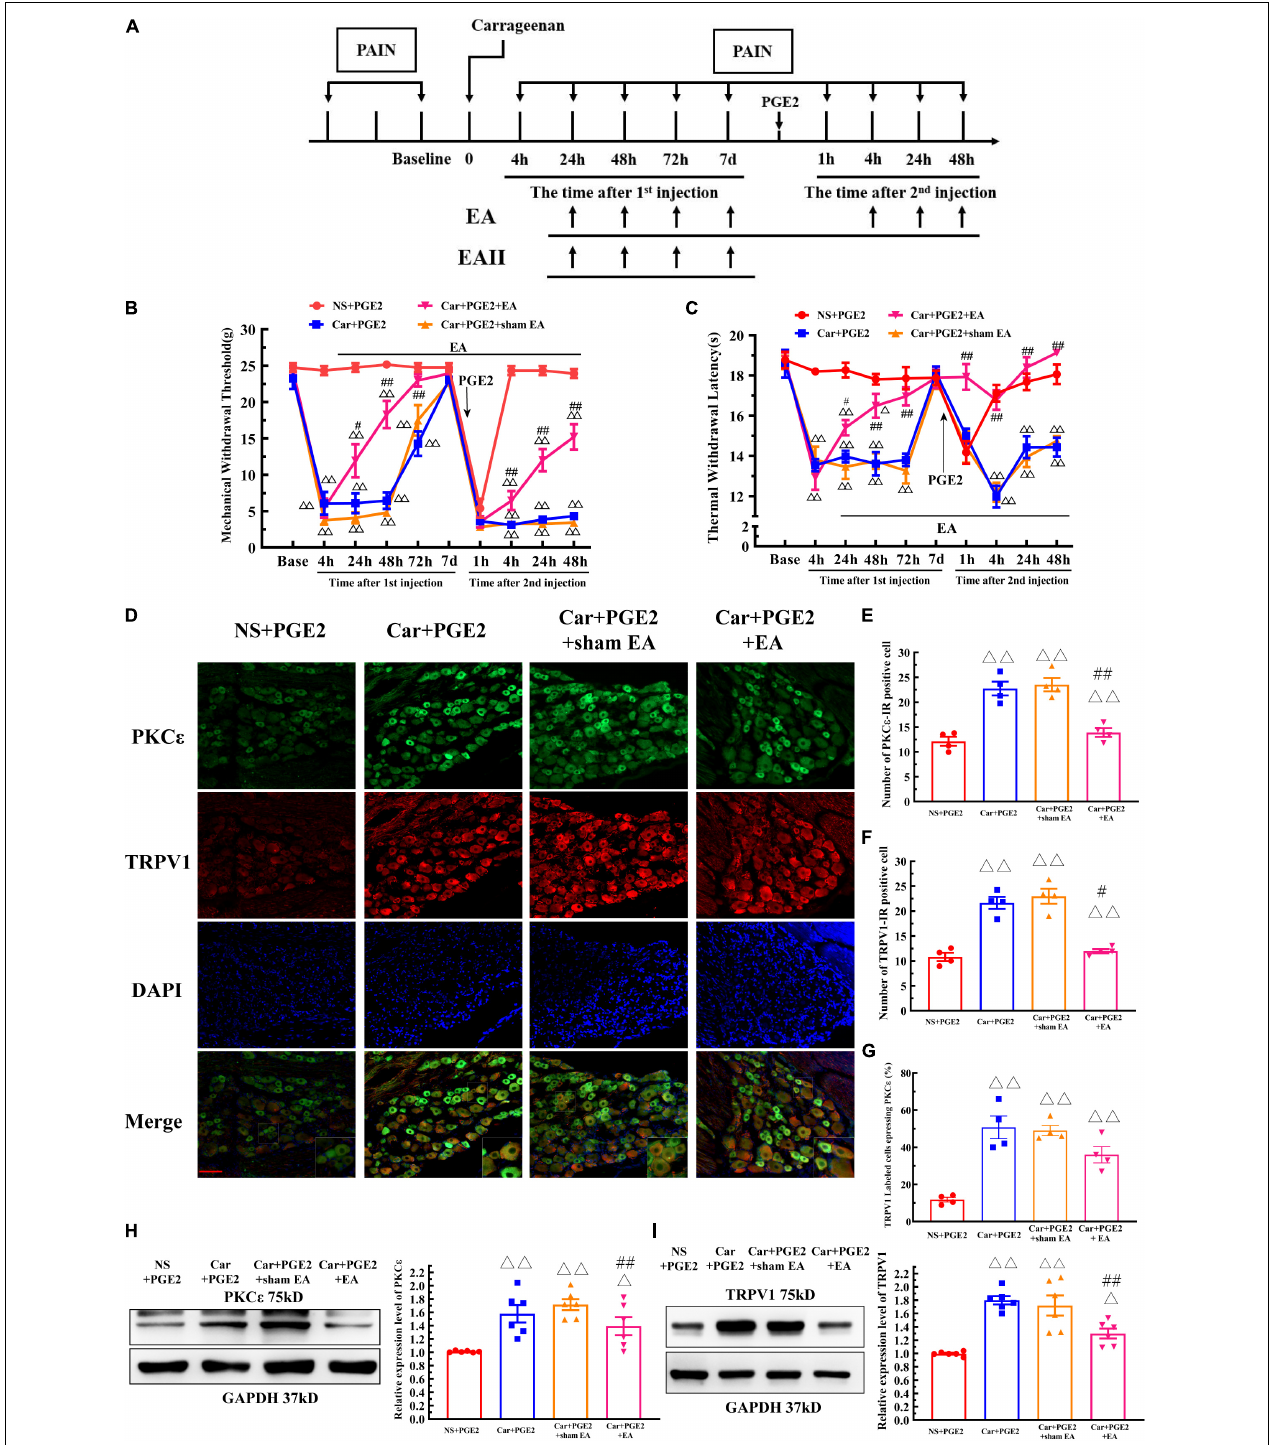
FIGURE 6 | Electroacupuncture (EA) regulates the transition from acute to chronic pain and the PKC ε activation and TRPV1 expression in the DRG. The protocol of EA administration (A) . Mechanical (B) and thermal (C) responses of hyperalgesic priming model animals to EA and sham EA administration. n = 5–6. (D) PKC ε and TRPV1 staining in the peripheral nervous system 48 h after PGE2 injection. Scale bar 100 µ m. The quantification of PKC ε –IR positive (E) and TRPV1–IR positive (F) neurons. The quantification of the ratio of TRPV1 labeled cells expressing PKC ε (G) . The quantification of the Western blot results and a representative Western blot showing PKC ε (H) and TRPV1 (I) protein isolated from the DRG 48 h after PGE2 injection. (cid:52) , (cid:52)(cid:52) Compared with the NS+PGE2 group, P < 0.05, P < 0.01; # , ## compared with the Car+PGE2 group, P < 0.05, P < 0.01.